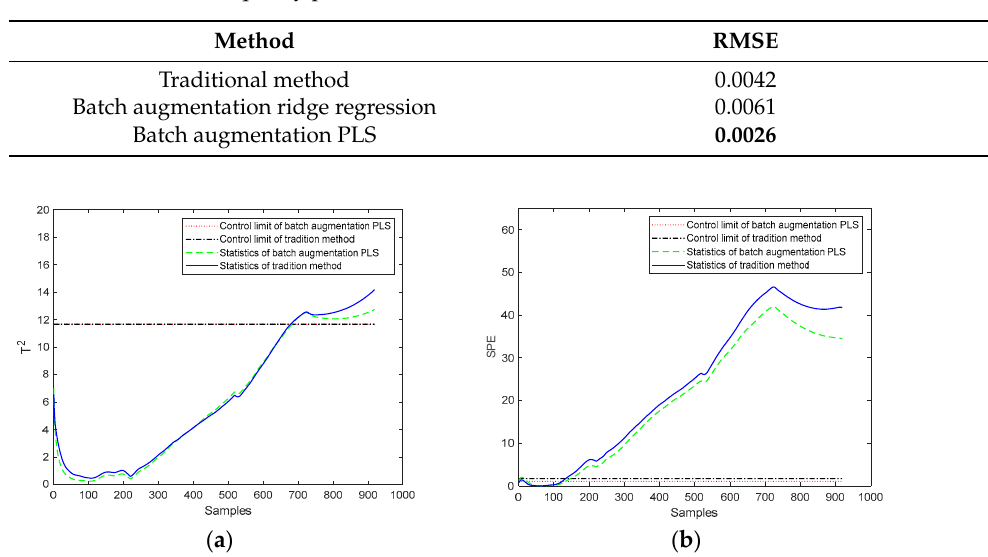
Figure 13. Final quality predictions. Table 6. RMSE of final quality predictions.